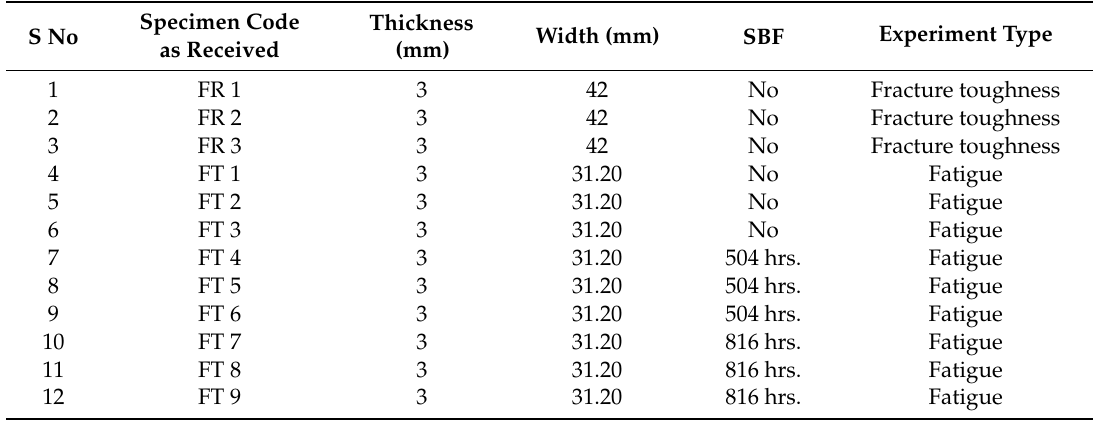
Table 2. The test matrix for fracture and fatigue crack growth test of Ti-27Nb.